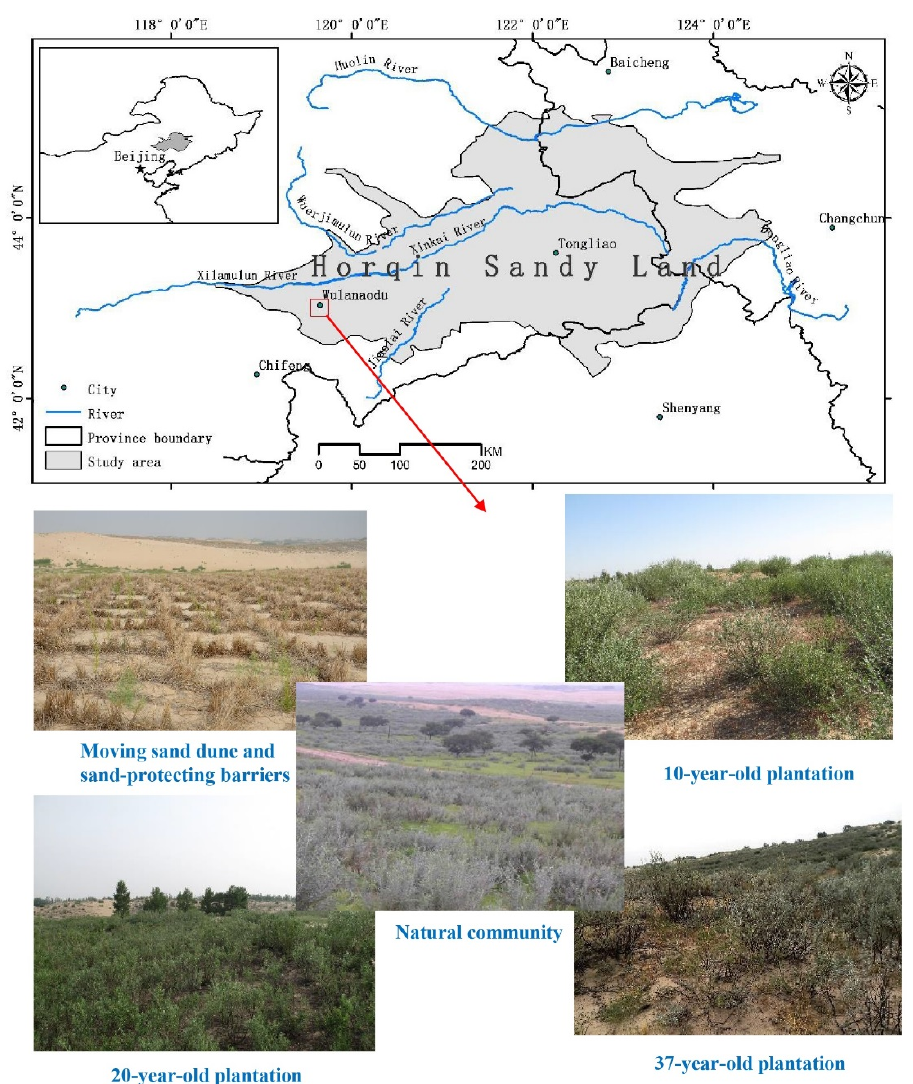
Figure 1 . Study location and sites (Geographical location map was provided by Dr. Renhui Miao).